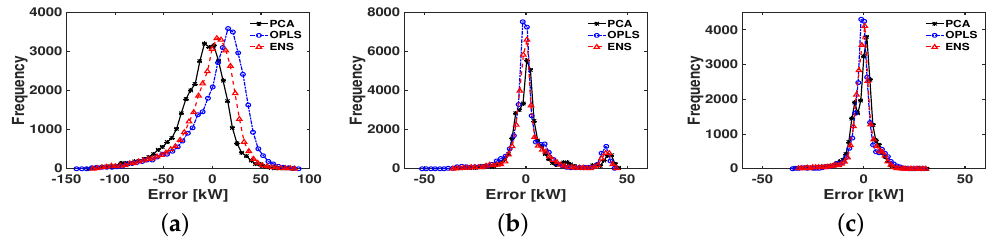
Figure 3. Comparison of residual analysis distributions in terms of the histograms for the three analyzed methods: Hospital Universitario de Fuenlabrada (HUF) ( a ); Centro de Especialidades